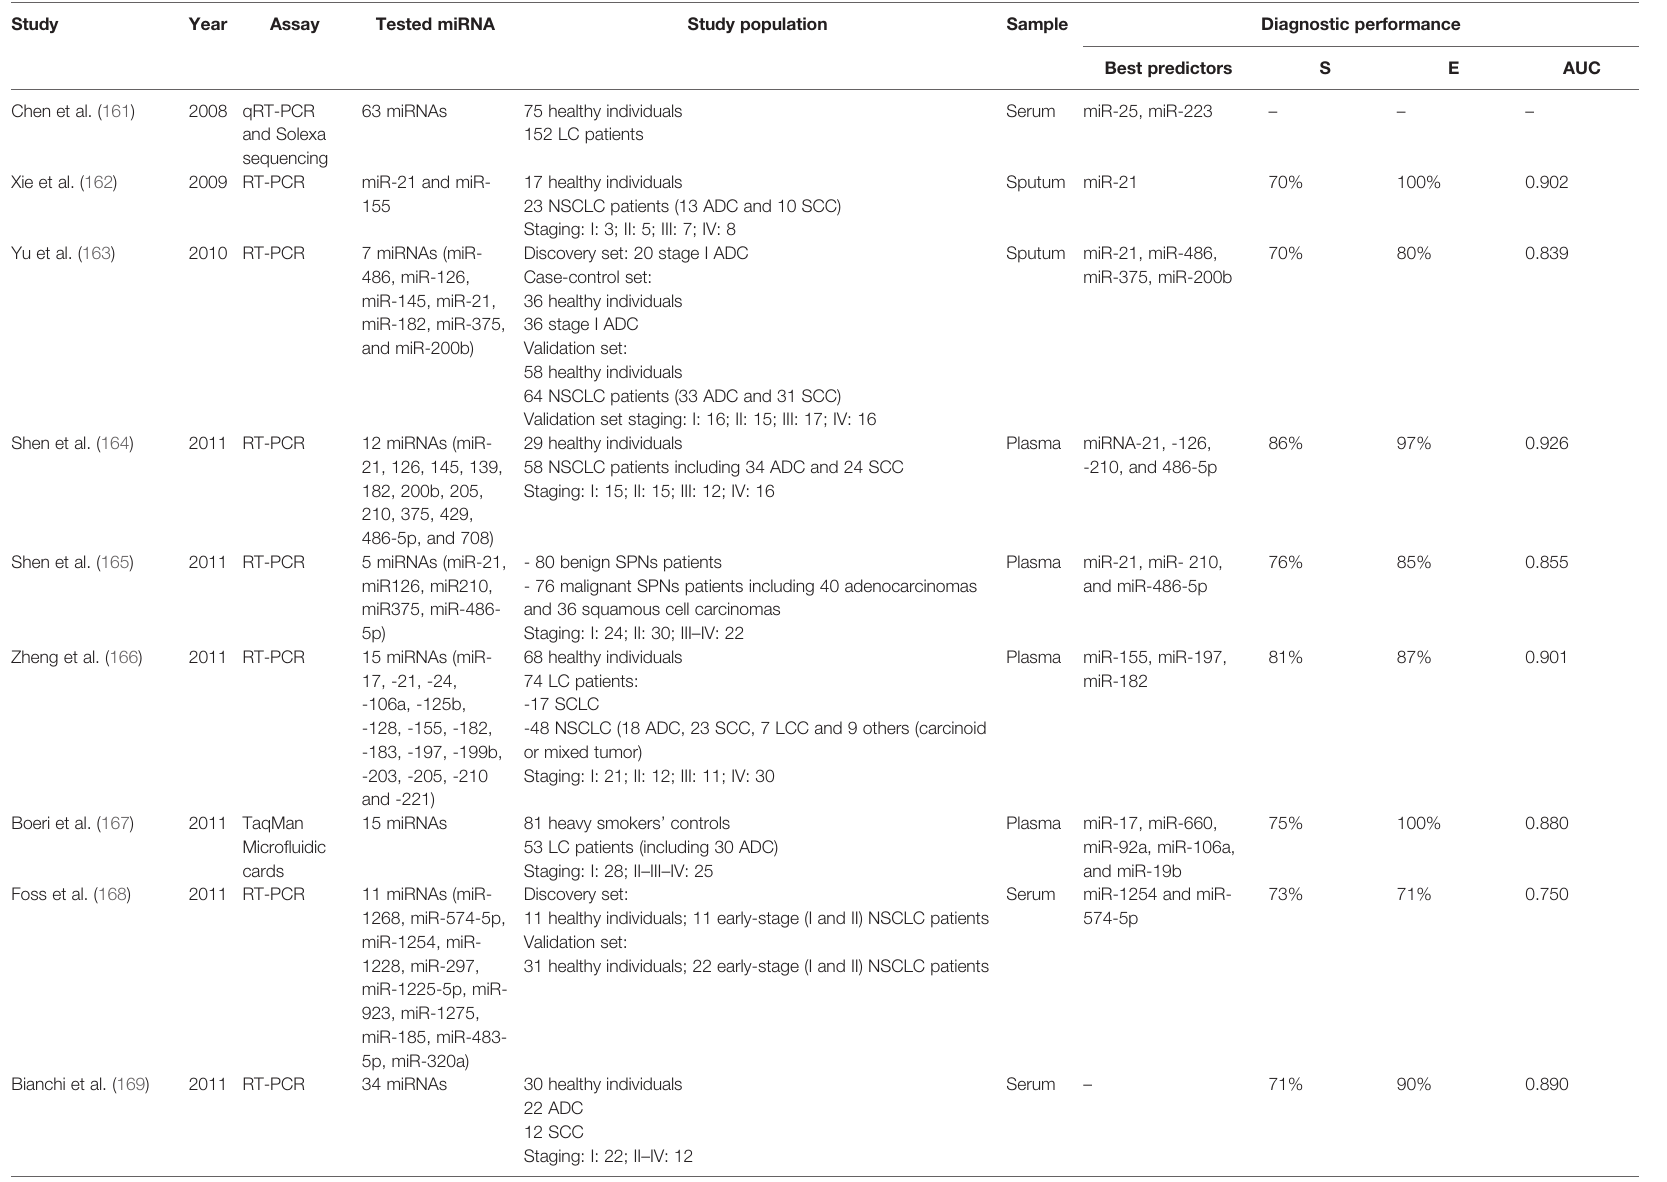
TABLE 6 | MicroRNA (MiRNA) as biomarker for lung cancer